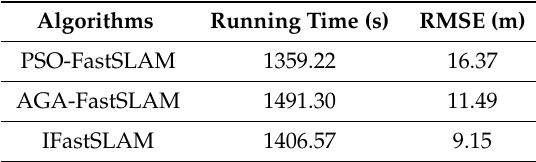
Figure 10. The Victoria Park dataset validation results. ( a ) PSO-FastSLAM. ( b ) AGA-FastSLAM. ( c ) IFastSLAM. Table 2. Comparison of RMSE and running time with Voctoria Park dataset.